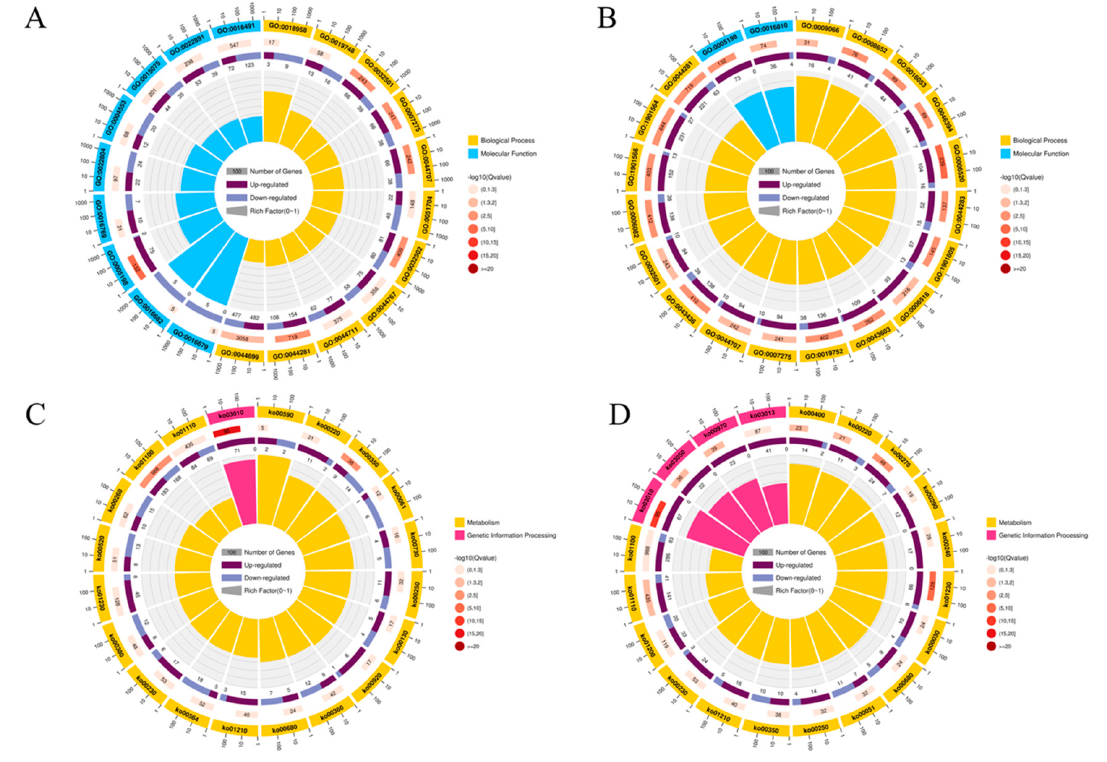
Figure 7. The Gene Ontology (GO) enrichment analyses in the CK − 1 vs. MT − 1 group ( A ) and CK − 2 vs. MT − 2 group ( B ), and Kyoto Encyclopedia of Genes and Genomes (KEGG) pathway enrichment analyses in the CK − 1 vs. MT − 1 group ( C ) and CK − 2 vs. MT − 2 group ( D ) of differentially expressed genes.